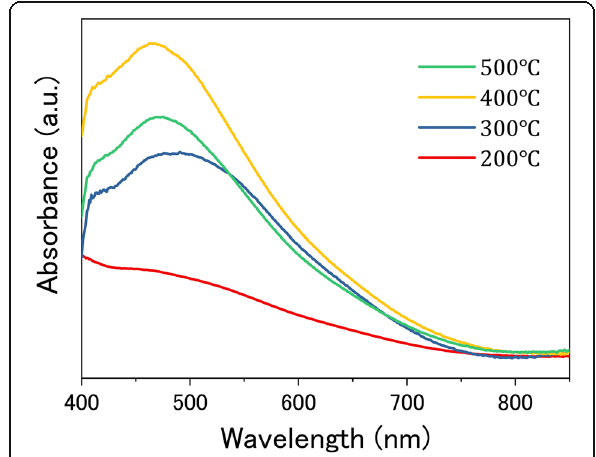
Fig. 5 UV-vis absorption spectra of TiO 2 /CIS photoelectrodes with annealing treatment at different